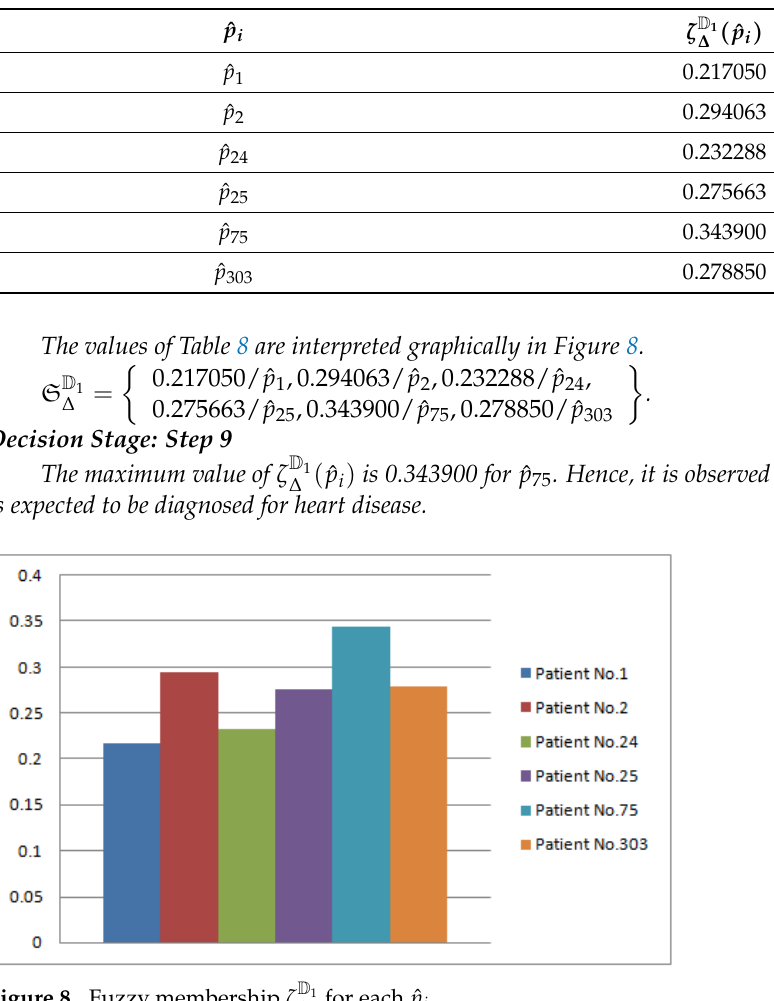
D 1 ∆ for each ˆ p i .